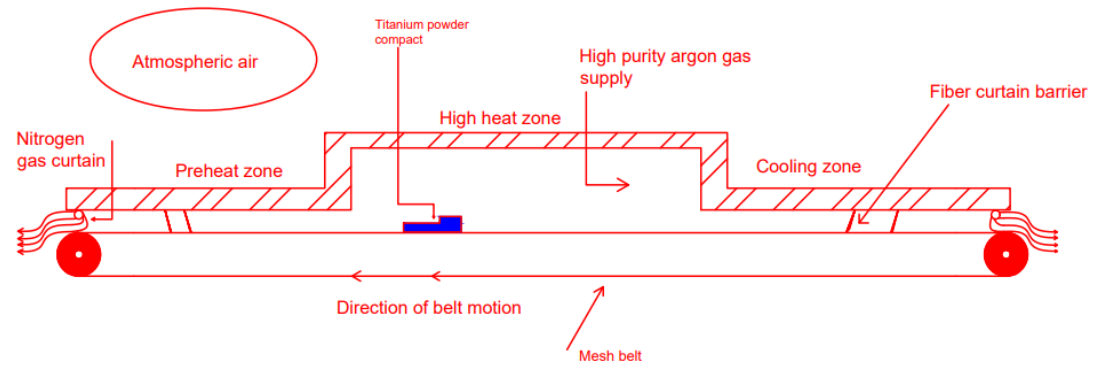
Figure 14. A continuous mesh belt furnace (adapted from